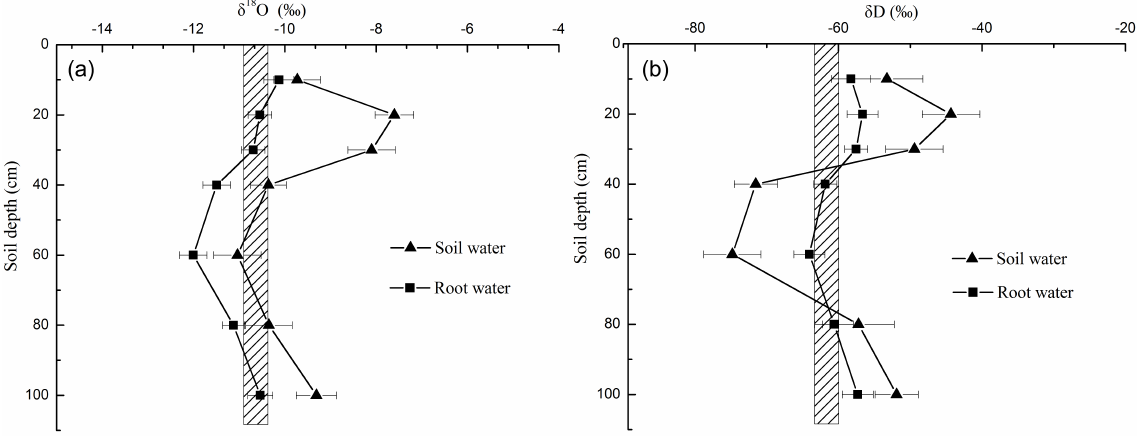
Figure 3. Isotope profiles of δ 18 O and δ D (piston-type flow) in soil water and xylem water. Values are mean ± 1 standard deviation ( n = 27).